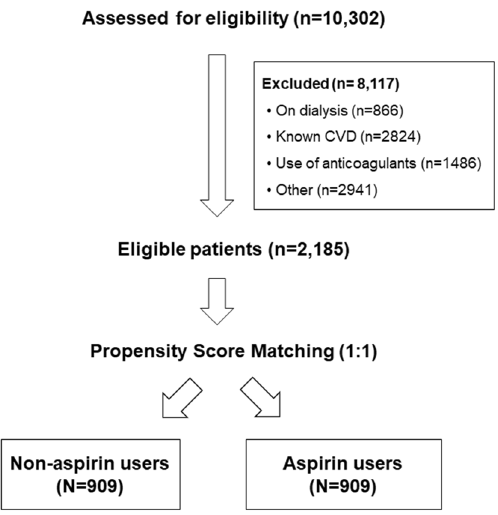
Figure 1. Flow chart of study participants. Electronic medical records of 10,302 patients with CKD treated at Meir Medical Center from January 2014 to December 2018 were evaluated. Excluded were 8,117 patients due to end-stage kidney disease treated by dialysis; previous CVD chronic use of anti-coagulants; chronic use of anti- platelet treatment that is not aspirin, or unavailable for follow-up were classified as